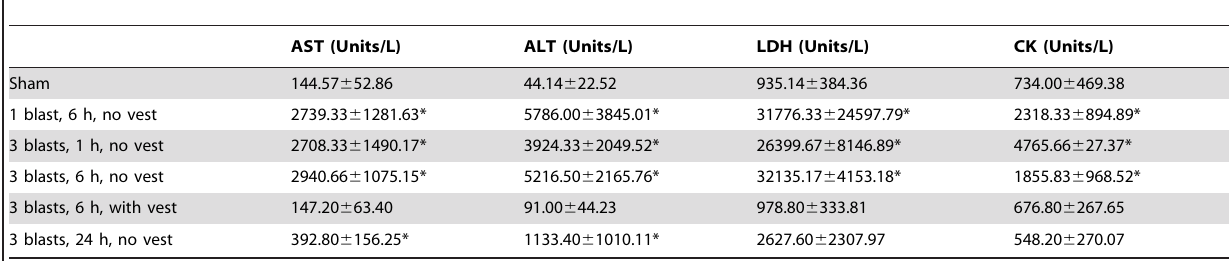
Table 1. Enzyme activities in the plasma at different time intervals after single and repeated blast exposures at 21 psi with and without protective